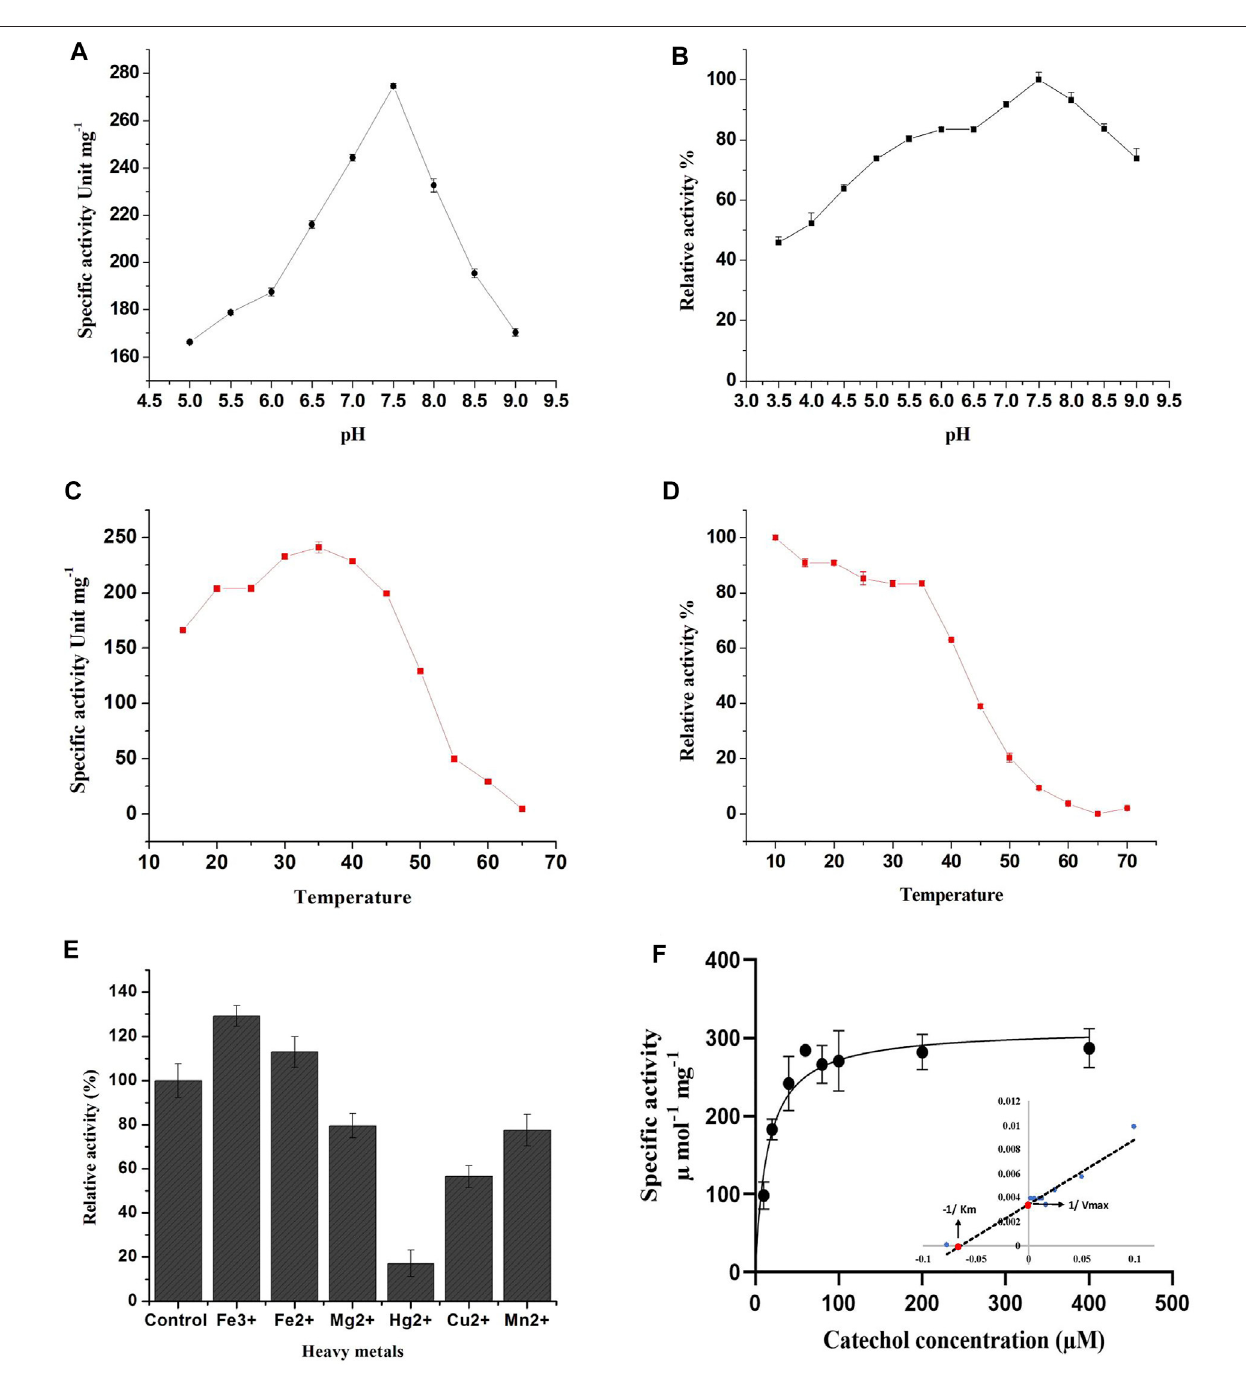
FIGURE 2 | Effect of pH, temperature and metal ions on recombinant C12O activity. (A) pH optima, (B) pH stability, (C) Temperature optima, (D) Temperature stability, (E) Effect of metal ions, (F) Determination of enzyme kinetic constants. Inlet: Lineweaver-Burk plot for the determination of K m and V max. The residual relative activity of enzyme was determined by the standard assay and compared with the highest activity of the enzyme displayed at different conditions. All the assays were performed in triplicate and the values are presented as mean ± SEM.